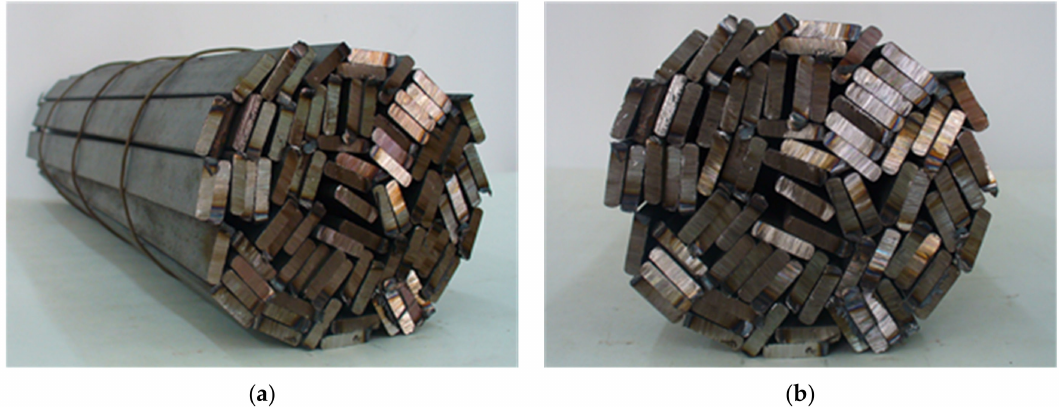
Figure 1. Model of the bundle of rectangular bars: ( a ) a general view, ( b ) a frontal